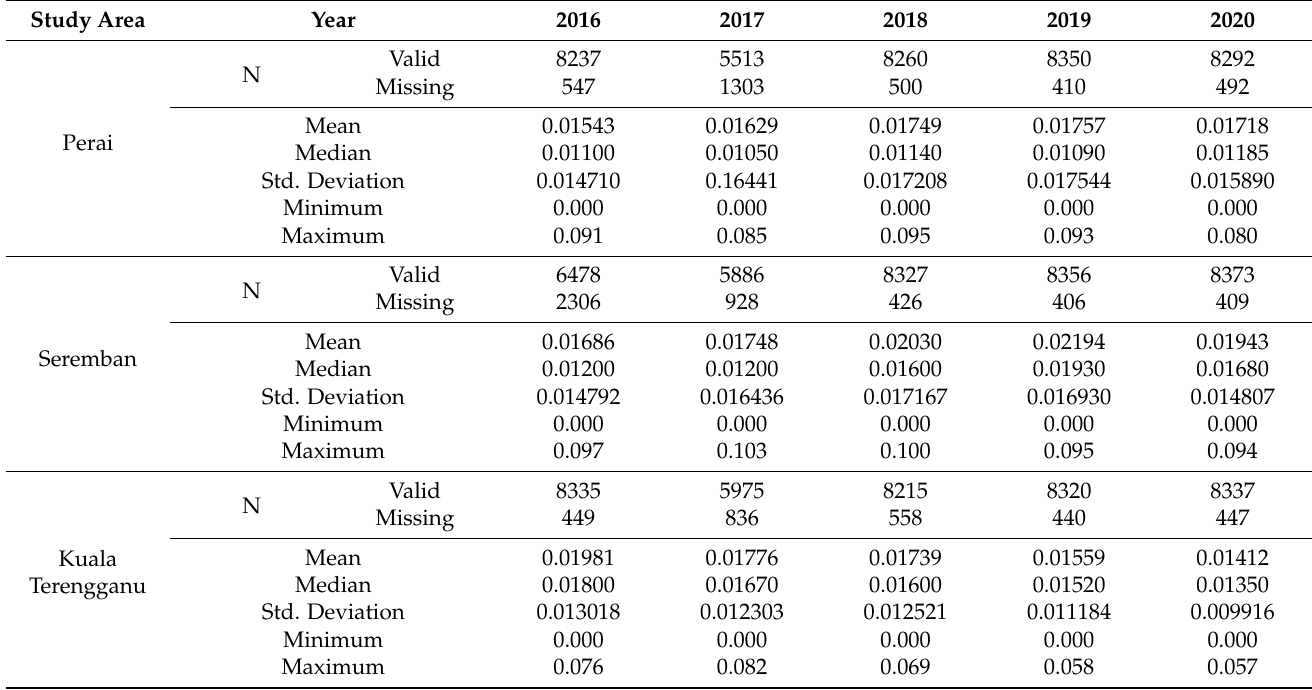
Table 4. Descriptive statistic of ground-level ozone concentration in Perai, Seremban, and Kuala Terengganu from 2016 to 2020.